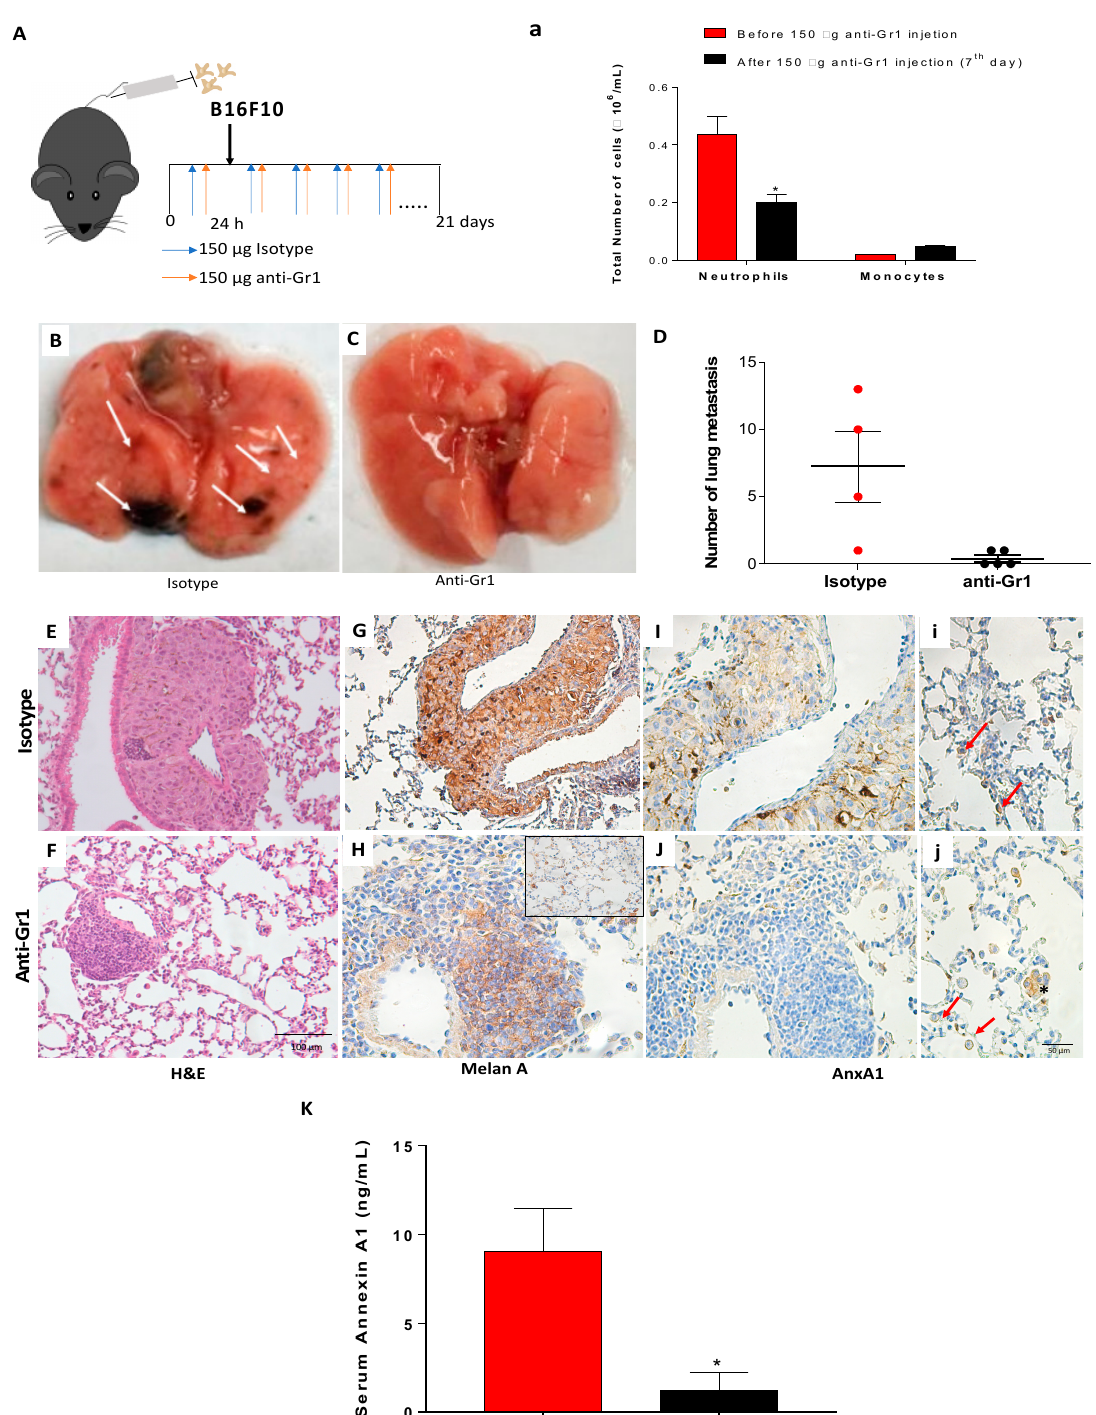
Figure 5. Neutrophil depletion reduced the number of melanoma lung metastasis and serum AnxA1 levels. ( A ) Experimental design. ( a ) Total number of neutrophils and monocytes in peripheral blood. ( B , C ) Images of the lungs from isotype or anti-Gr1-treated mice. ( D ) Number of melanoma metastasis spots. ( E , F ) Morphologic analysis by H&E staining. ( G , H ) Representative images of the Melan A expression ( I , i ) in isotype and ( J , j ) neutrophil-depleted mice. Insert: Melan A expressed in cells spread into the lungs. Red arrows: immune cells labeled for AnxA1. ( K ) Serum levels of AnxA1. The data represented the average ± SEM. * p < 0.05 vs. isotype. Melanoma group ( n = 4, 5). Melanoma neutrophil-depleted group ( n =